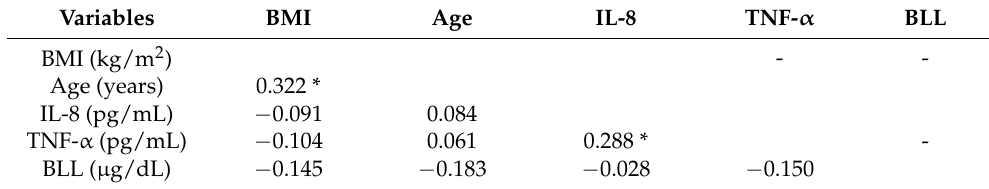
Table 2. Correlations of cytokines and independent variables in females ( n = 68).